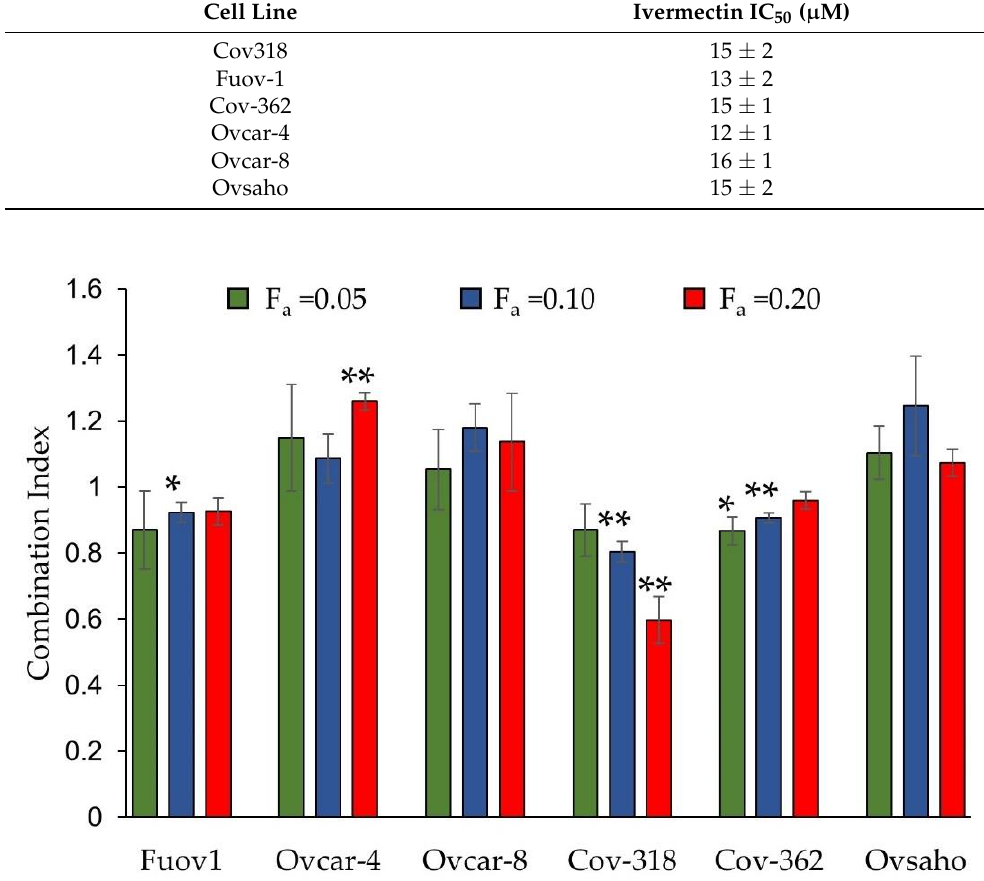
Figure 1. Evaluation of the combination of pitavastatin and ivermectin in cell growth assays. The indicated cells were simultaneously exposed for 72 h to a range of pitavastatin concentrations with a fixed concentration of ivermectin which, on its own, inhibited cell growth by 5%, 10%, and 20%. These concentrations were respectively: FUOV-1 (4.4 µM, 6.2 µM, and 8.8 µM); Ovcar-4 (4.2 µM,